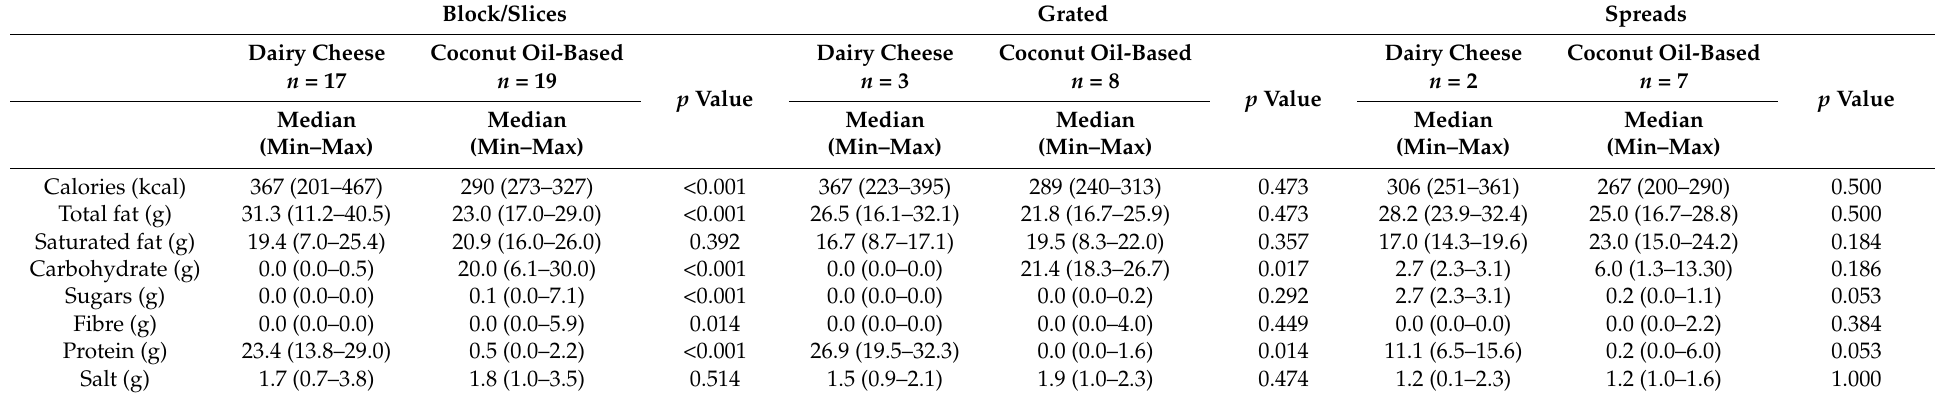
Table 3. Median (minimum-maximum) values of calories and nutritional content in dairy cheese and coconut oil-based cheese alternatives per 100 g, by format.